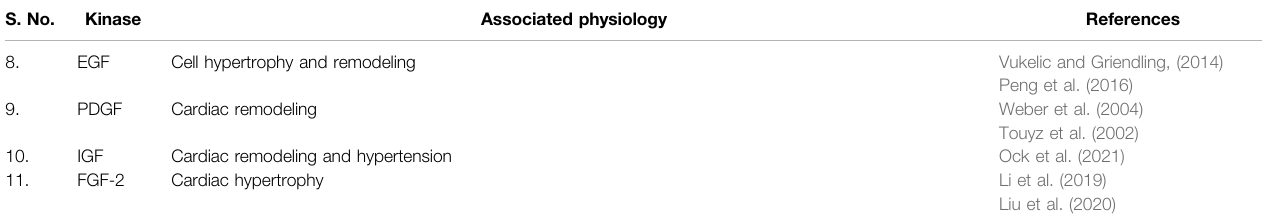
TABLE 2 | ( Continued ) Identi fi ed protein kinases in ANG II signaling in cardiovascular system. S.